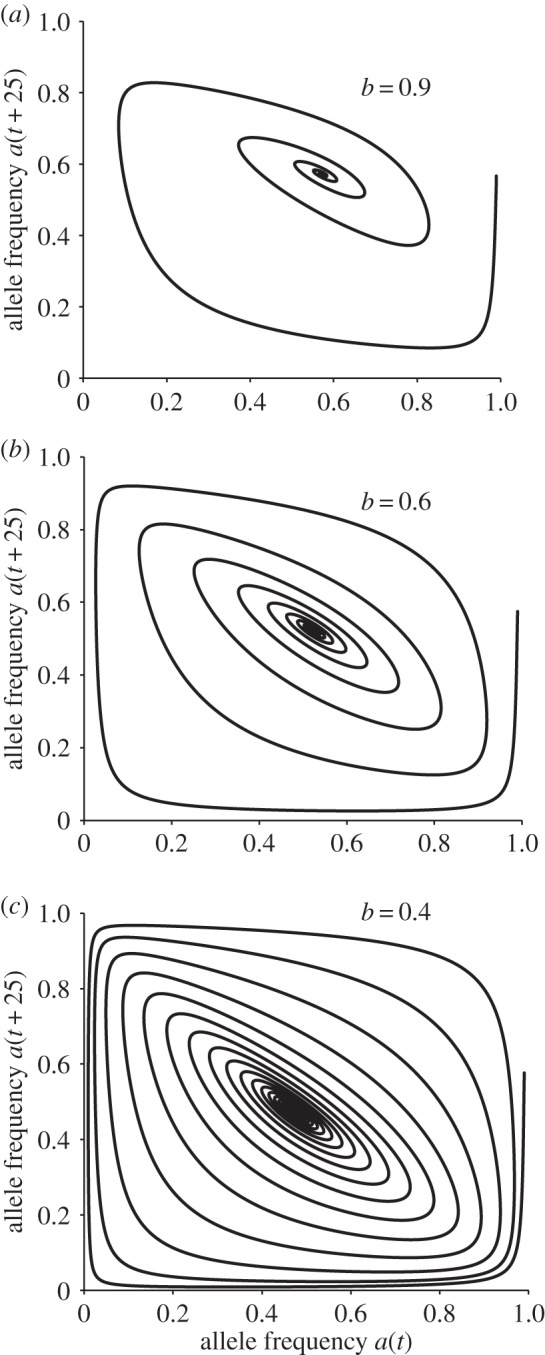
Cyclic dynamics of asexuals, a, towards the equilibrium in a mixed strategy S1/S2/S3. We displayed a(t+25) versus a(t) to show the transition dynamics towards the attractor point. Simulation runs for α=k=0.5, m=3.1 and R=1.3 and three values of the b parameter: (a) b=0.9, (b) b=0.6 and (c) b=0.4. The main effect of the decrease in b is a high increase of the transitory phase, but a short decrease in the proportion of asexuals.